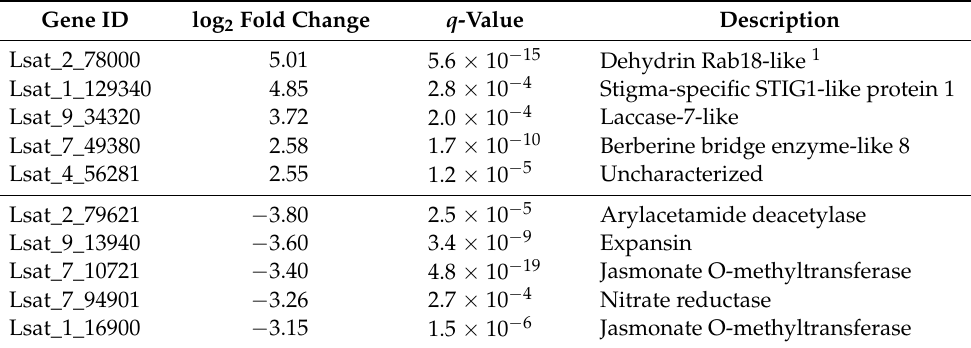
Figure 4. Relative expression of DHN s during dehydration in lettuce. The relative expression of DHN was compared via RNA-seq. The expression levels of DHN were compared with the fragments per kilobase per million reads (FPKM) between the control (white) and drought stress (gray). Each relative FPKM was calculated on the basis of the control treatment of LsDHN9 and plotted on the axis of a logarithmic scale.